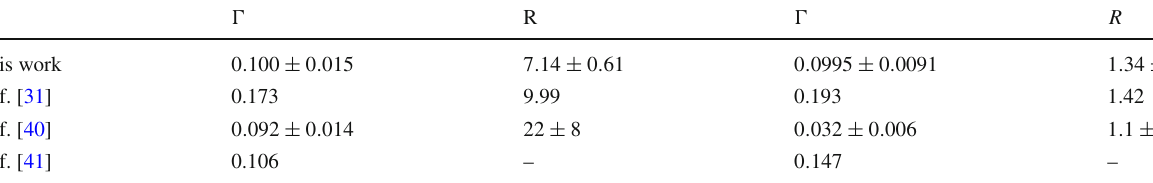
Table 4 The width (in unit 10 12 s − 1 ) of (cid:2) cc → (cid:2) c l ¯ ν l (left) and (cid:2) cc → (cid:2) (cid:3) c l ¯ ν l